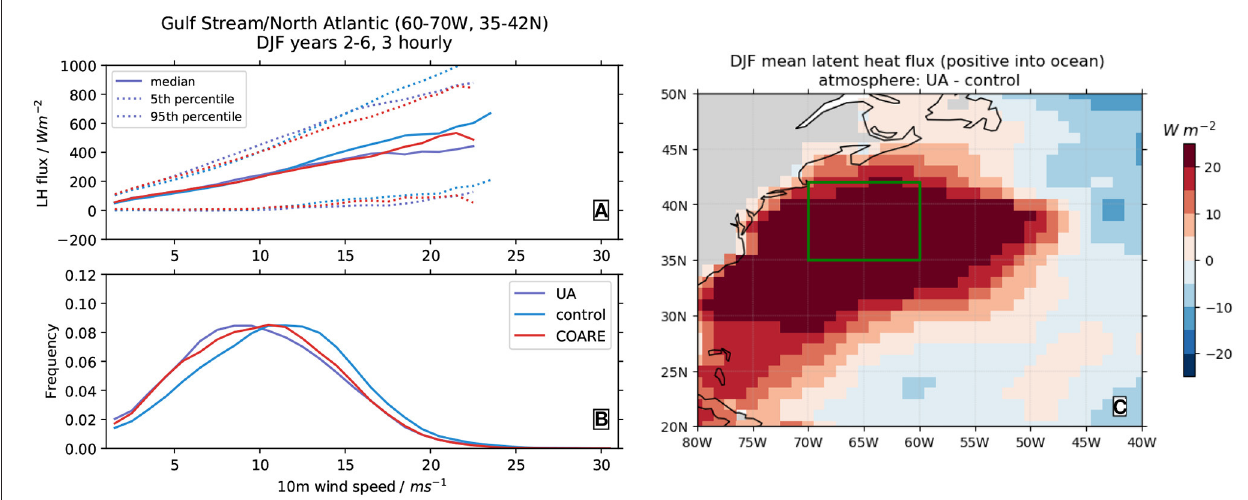
FIGURE 10 | (A) Latent heat flux quantiles, as functions of 10-m wind speed, and (B) 10-m wind speed distributions, for the three atmosphere simulations in a region around the Gulf Stream (60 − 70 ◦ W, 35 − 42 ◦ N). The quantiles and wind speed distribution are calculated from 3-hourly model output from the winter season (December, January, and February) over model years 2 − 6 of each simulation, binned into 1 m s − 1 bins. (C) December to February multi-year mean latent heat flux difference between UA and control atmosphere simulations, with the region used in (A,B) shown by the green box. Note that the heat flux sign convention in (A) is opposite to that used in (C) : positive values correspond to evaporation. The colors shown in the legend of (B) also apply to (A) .